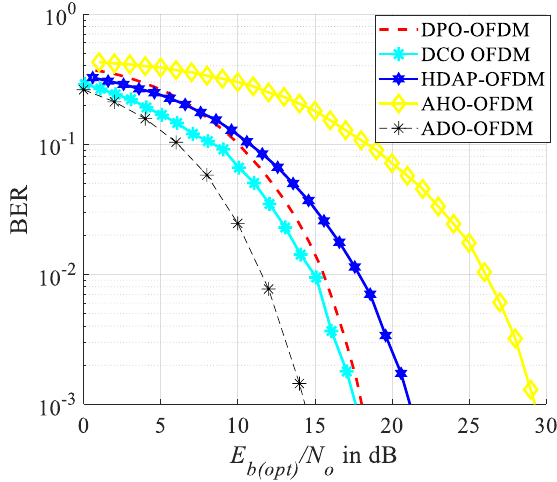
Figure 6. Bit error rate (BER) versus optical energy per bit to noise power spectral density ( E b ( opt ) / N 0 ) for different orthogonal frequency division multiplexing (OFDM) forms.